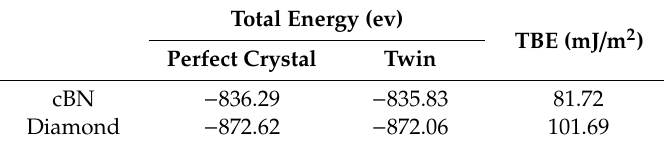
Figure 1. Atomic arrangement of cubic boron nitride (cBN) and twin cBN: ( a ) cBN, with two non-equivalent (111) planes, corresponding respectively to narrowly spaced atomic layer (glide-set) indicated by red line, and widely spaced atomic layer (shuffle-set) by blue line [42]. ( b ) nanotwinned cubic boron nitride (nt-cBN) with red lines as twin boundary (TBs). Table 1. Calculated total energies and TBEs of cBN and diamond.